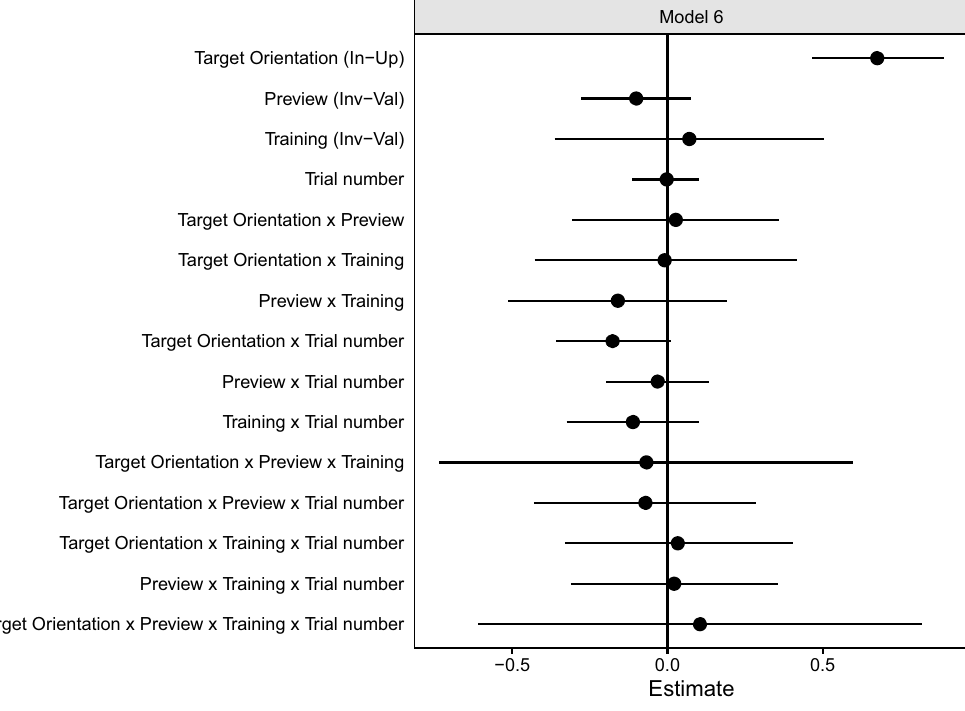
Figure 5. Fixed effect coefficients of the maximum identified generalized linear model on task errors (Model 6). Error bars represent 95% profile confidence intervals. Effect contrasts for each factor are given in brackets next to the names of main effects on the y-axis. In-Up Inverted minus upright, Inv-Val Invalid minus valid. For example, a positive estimate for the Target Orientation effect (inverted minus upright) means that there were more errors with inverted than with upright target